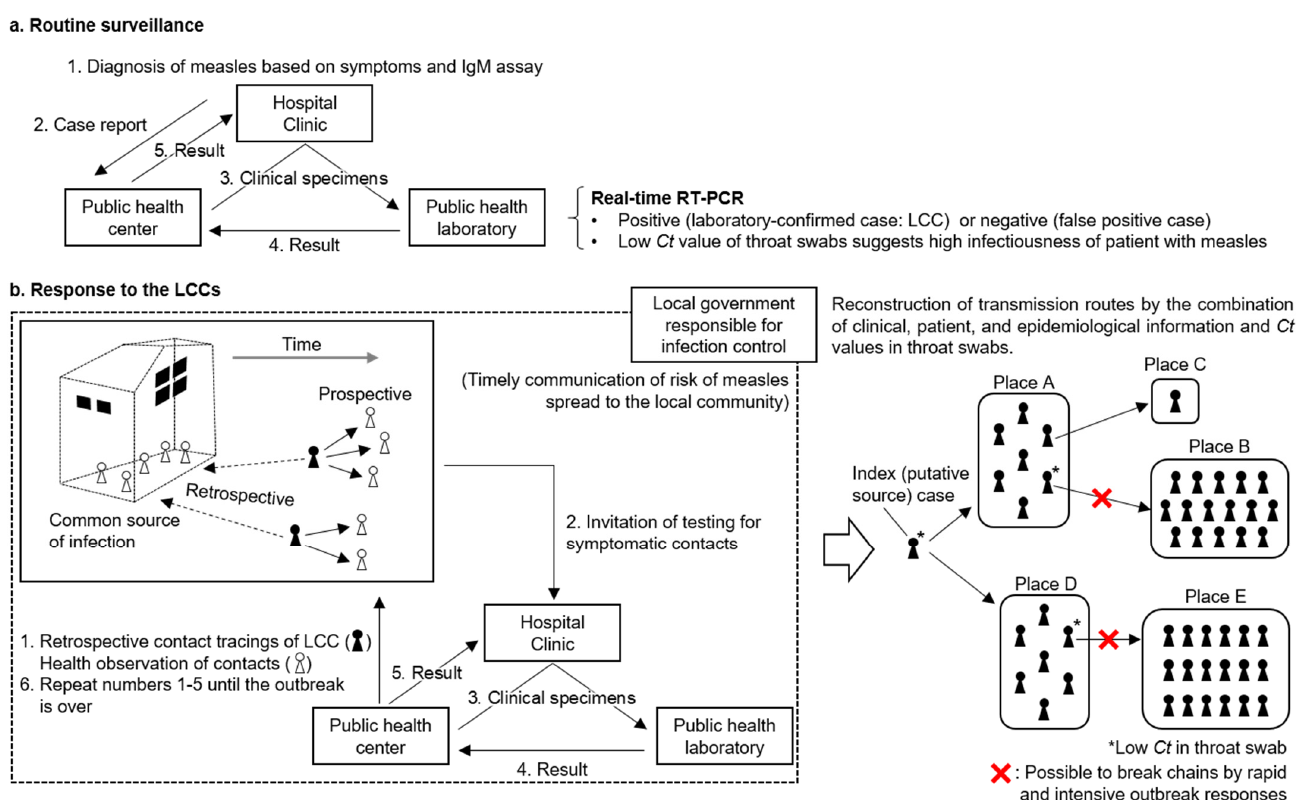
Figure 3. Assumed model for breaking the chain of measles transmission through the cooperation of clinical, epidemiologic, and laboratory diagnostic activities in the subnational regions of measles- eliminated countries. ( a ) In routine surveillance, quality-assured real-time RT-PCR contributes to the rapid and accurate diagnosis of acute measles cases. ( b ) Once a laboratory-confirmed case is detected, contacts and common sources of infection should be identified by retrospective and prospective contact tracings. The local government should timely communicate the risk of measles spreading to the local community until the end of measles transmission. Real-time RT-PCR should be conducted on symptomatic contacts as soon as possible. When a laboratory-confirmed case is estimated as a super-spreader candidate from the result of low Ct value (i.e., high viral load) in a throat swab, intensive outbreak responses to the contacts (e.g., strengthening quarantine, and test- ing in the asymptomatic phase) are expected to break the chain of transmission. These rapid and intensive responses would lead to the early end of measles outbreaks.